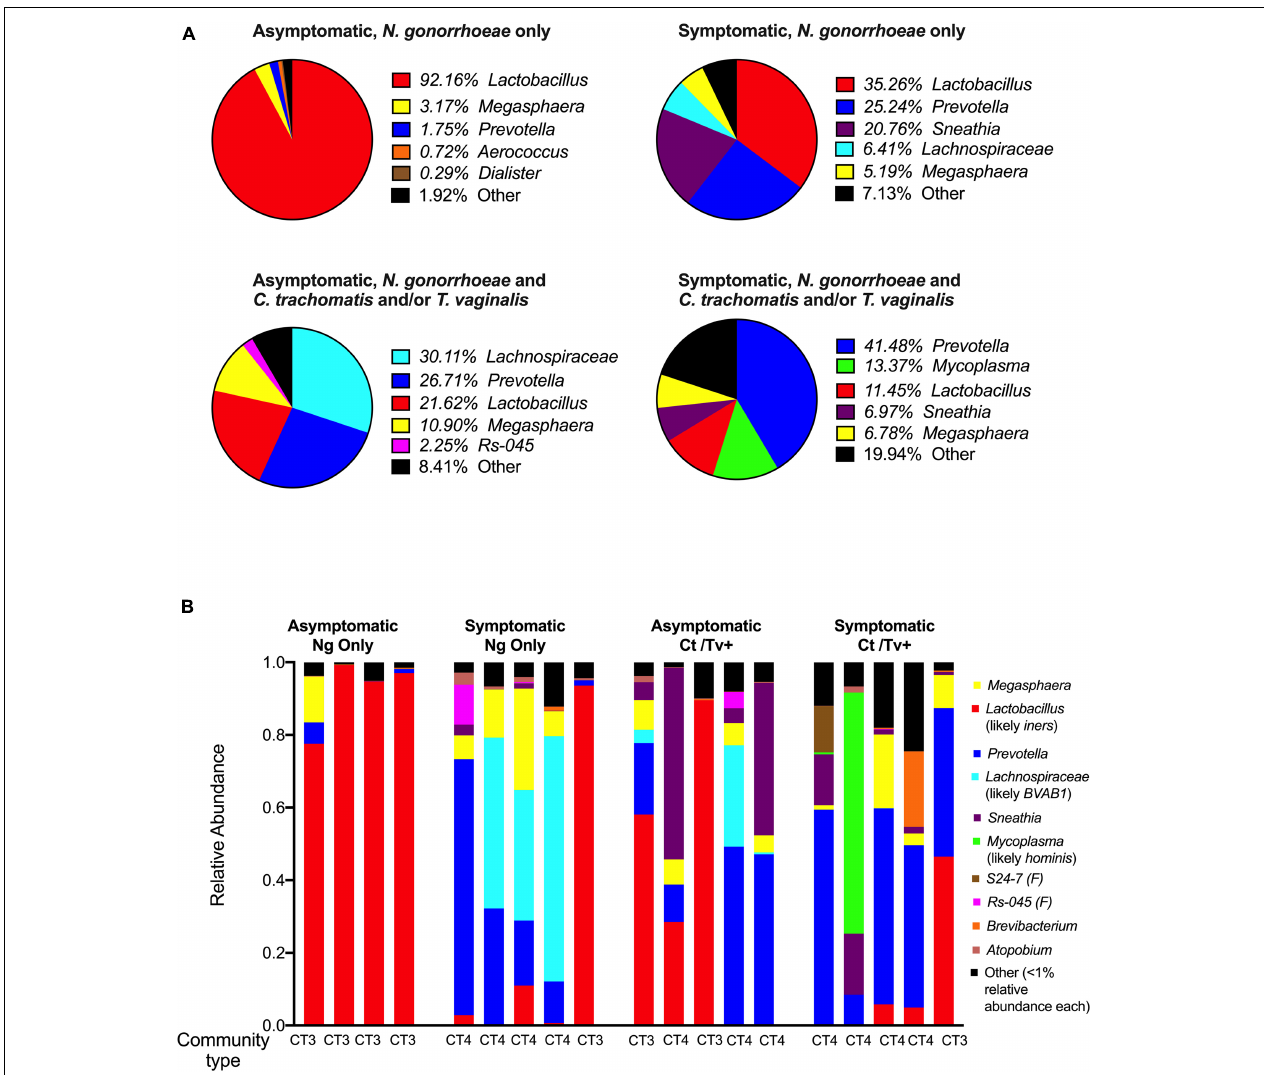
FIGURE 4 | Community composition of symptomatic and asymptomatic individuals with and without C. trachomatis and/or T. vaginalis co-infection. The mean relative abundances of the top five most prevalent bacterial genera identified within each patient group of interest are plotted as pie charts with each pie representing a group of interest (A) . The relative abundances of the top ten taxa (genera- or family-level taxa, as applicable) identified across all 16S rRNA sequencing reads in the dataset are shown for each of the 19 participants included in the study. These top 10 taxa comprised ł 99% of all reads in the entire dataset. We used BLAST and MUSCLE alignments to determine the likely species of communities dominated by Lactobacillus , Lachnospiraceae , and Mycoplasma and found them to be L. iners , Bacterial Vaginosis-Associated Bacterium-1 (BVAB1)/“ Candidatus Lachnocurva vaginae,” and M. hominis , respectively. The microbial community type (CT) designated for each participant, using standard definitions in the field, is provided